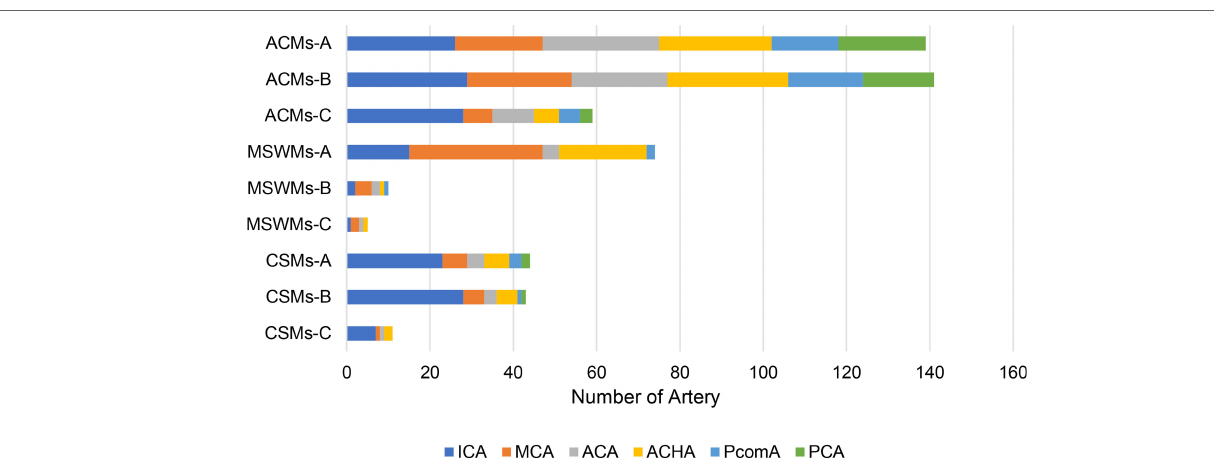
TABLE 1 | The relationship between the tumor and cerebral arteries in different PMs.